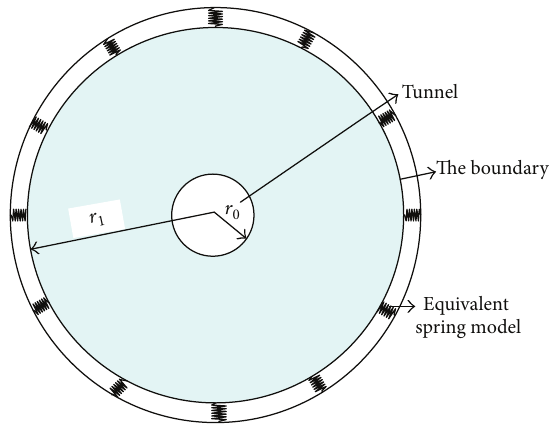
Figure 1: Equivalent spring model on the boundary of tunnel